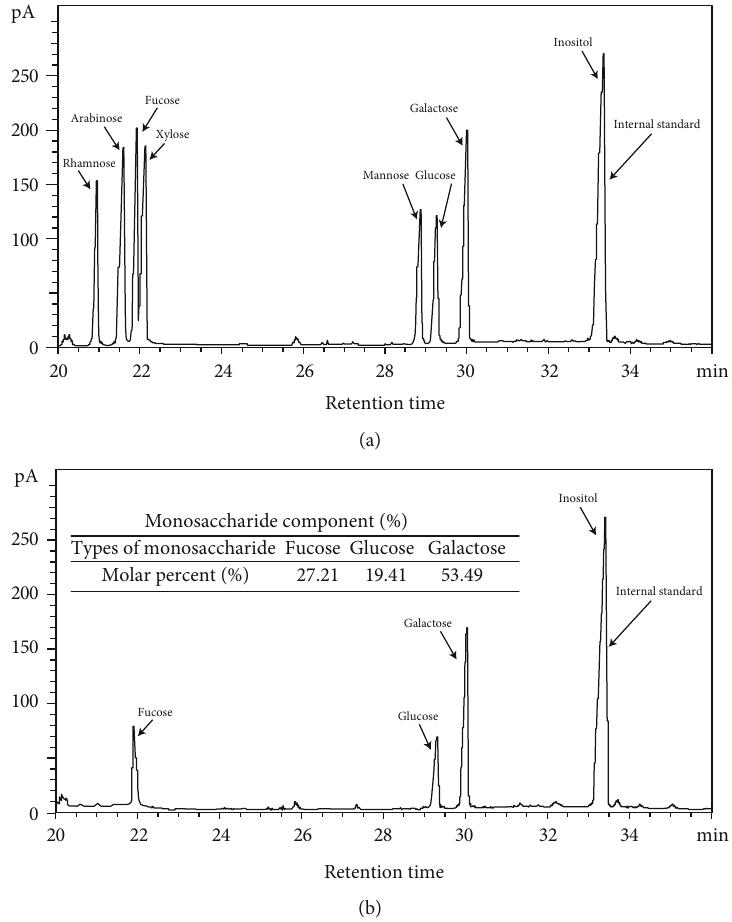
Figure 1: Gas chromatograms of monosaccharide standards (a) and SPUP hydrolysates